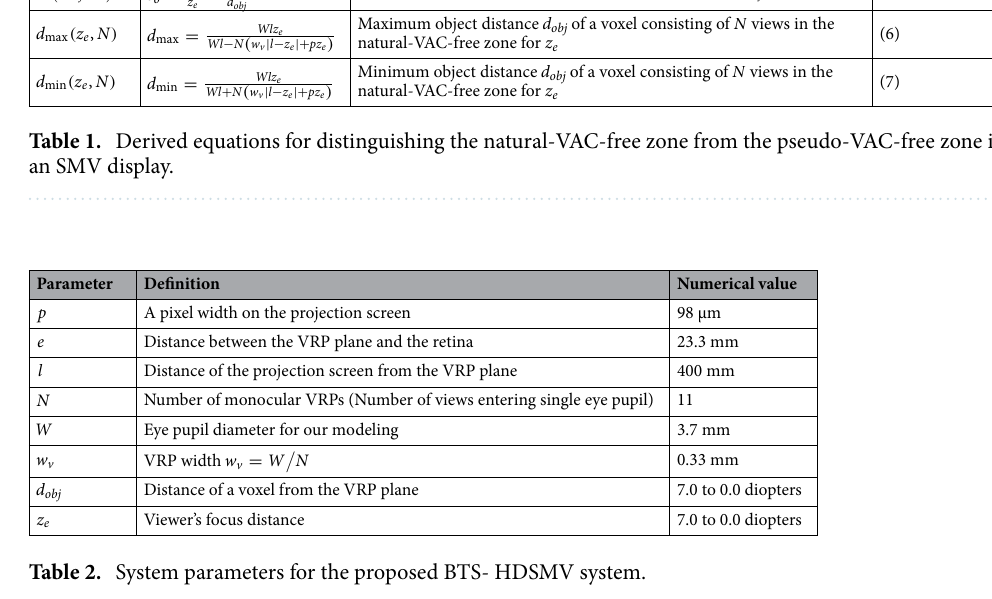
Fig. 6. Table 1 summarizes the derived equations. (See Supplementary Information for the full derivation of these equations). The system parameters for the proposed BTS HDSMV system are listed in Table 2, with the numerical values derived from numerical simulations. Plotting Eqs. (4)-(7) allows the dimensions of the natural-VAC-free zone to be determined (Fig. 7). It is